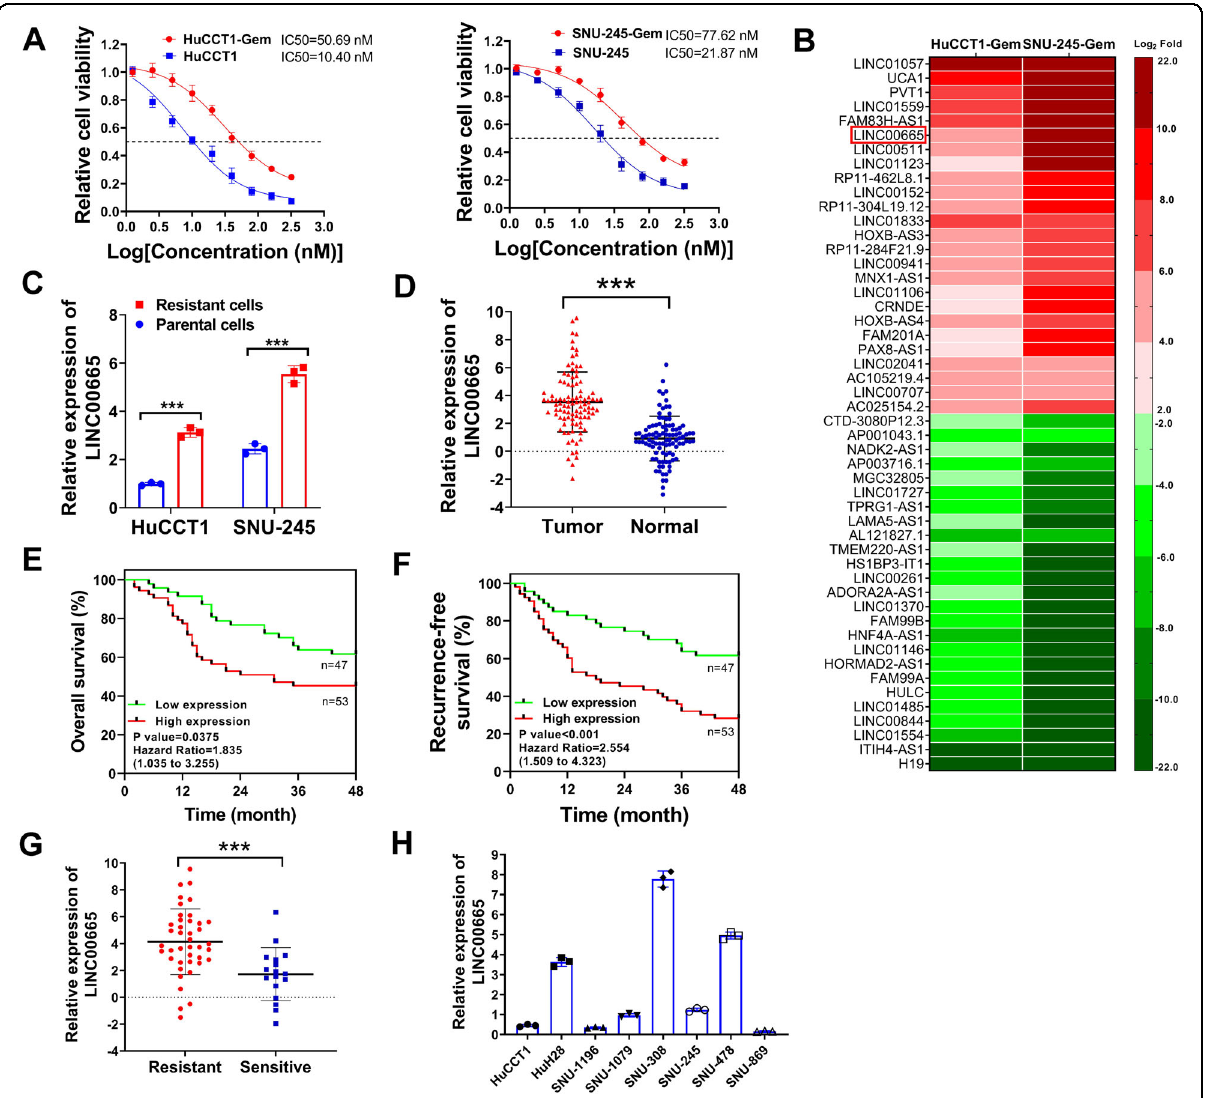
Fig. 1 LINC00665 is upregulated and associated with poor prognosis and chemoresistance in CCA patients. A HuCCT1, HuCCT1-Gem, SNU- 245, and SNU-245-Gem cells were seeded in 96-well plates (5000 cells/well) and exposed to 0, 1.25, 2.50, 5.0, 6.25, 10, 20, 40, 80, 160, and 320 nM gemcitabine for 6 d, then assayed for cell viability. B heat map shows the top 50 dysregulated lncRNAs in HuCCT1-Gem and SNU-245-Gem cells identi fi ed by lncRNA microarray. C relative expression of LINC00665 in parental or resistant HuCCT1 and SNU-245 cells was evaluated by qRT-PCR. D relative expression of LINC00665 in 100 cholangiocarcinoma samples (Tumor) and paired adjacent non-cancerous tissues (Normal) was evaluated by qRT-PCR. E , F Kaplan – Meier survival analysis of CCA patients according to LINC00665 expression. Overall survival ( E ) and recurrence-free survival ( F ) were shown. G relative expression of LINC00665 in chemotherapy-resistant or sensitive CCA patients was shown. H relative expression of LINC00665 in CCA cell lines. *** P ≤